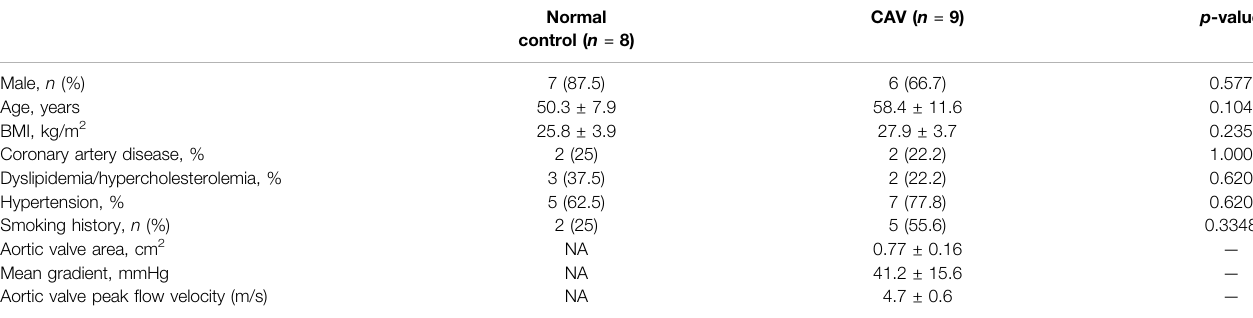
Continuous variables are expressed as means ± SD. Dichotomous variables are expressed as